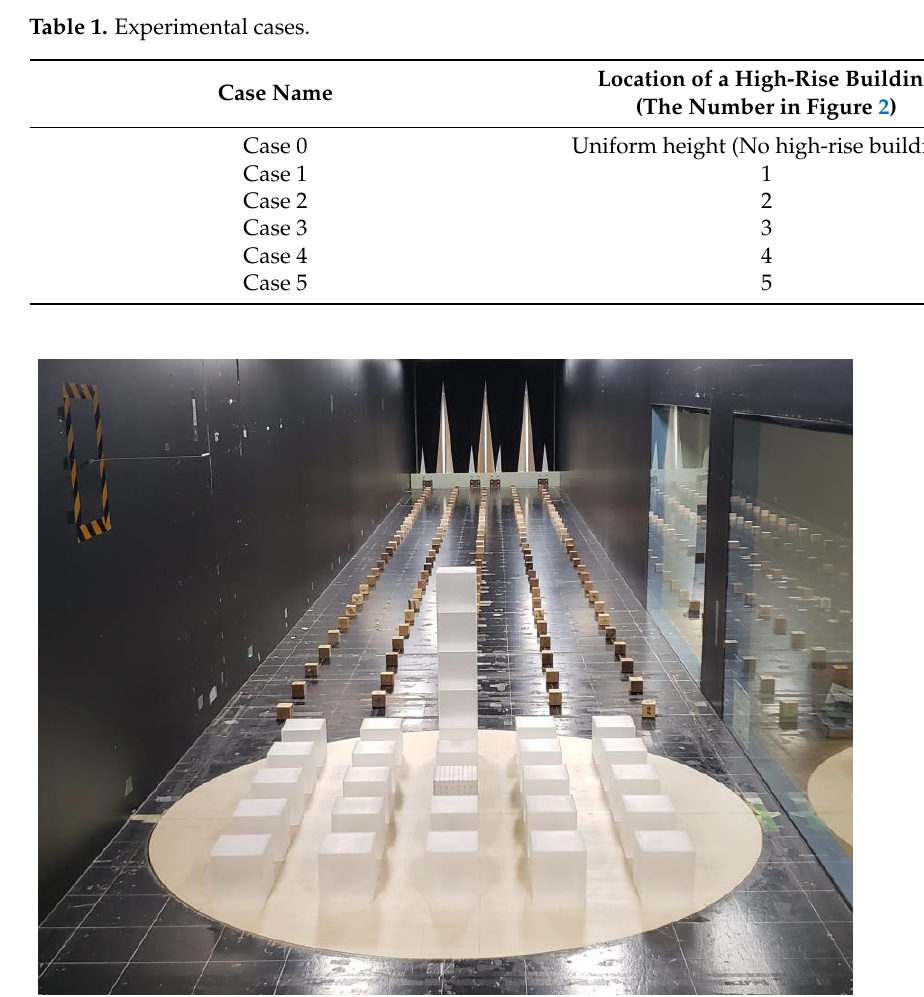
Figure 3. Photo of the experimental models installed in the wind tunnel of Case 1.